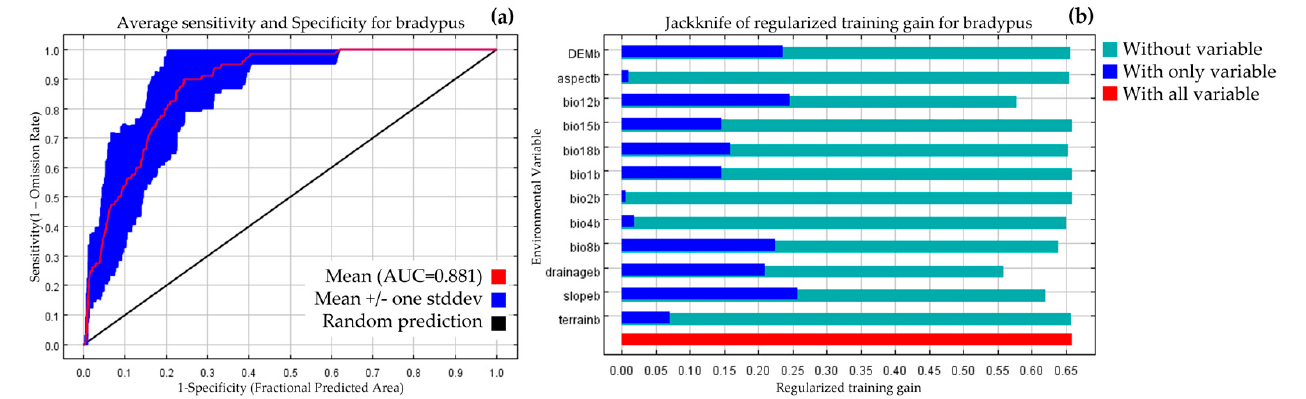
Figure A1. The receiver operating characteristic (ROC) curve of A. pictum ( a ); the Jackknife tests the importance of the training of variables to distribution of A. pictum ( b ).